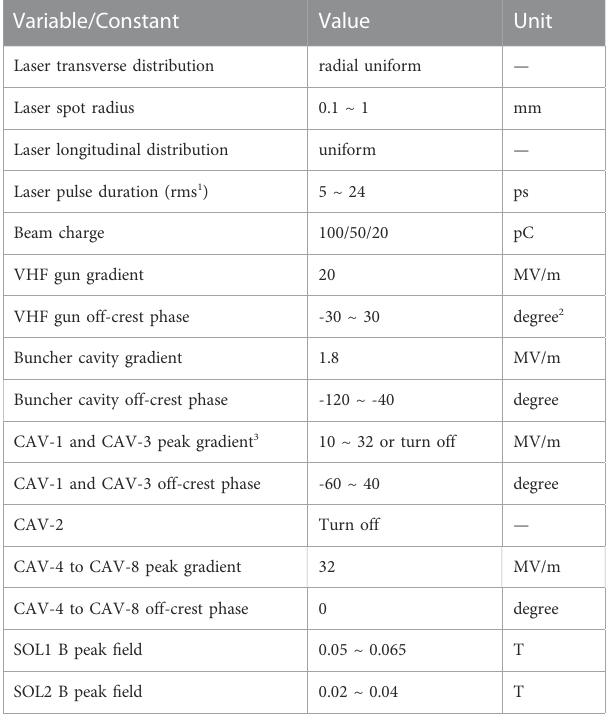
TABLE 1 Optimization variables and constants in the LCLS-II photoinjector.